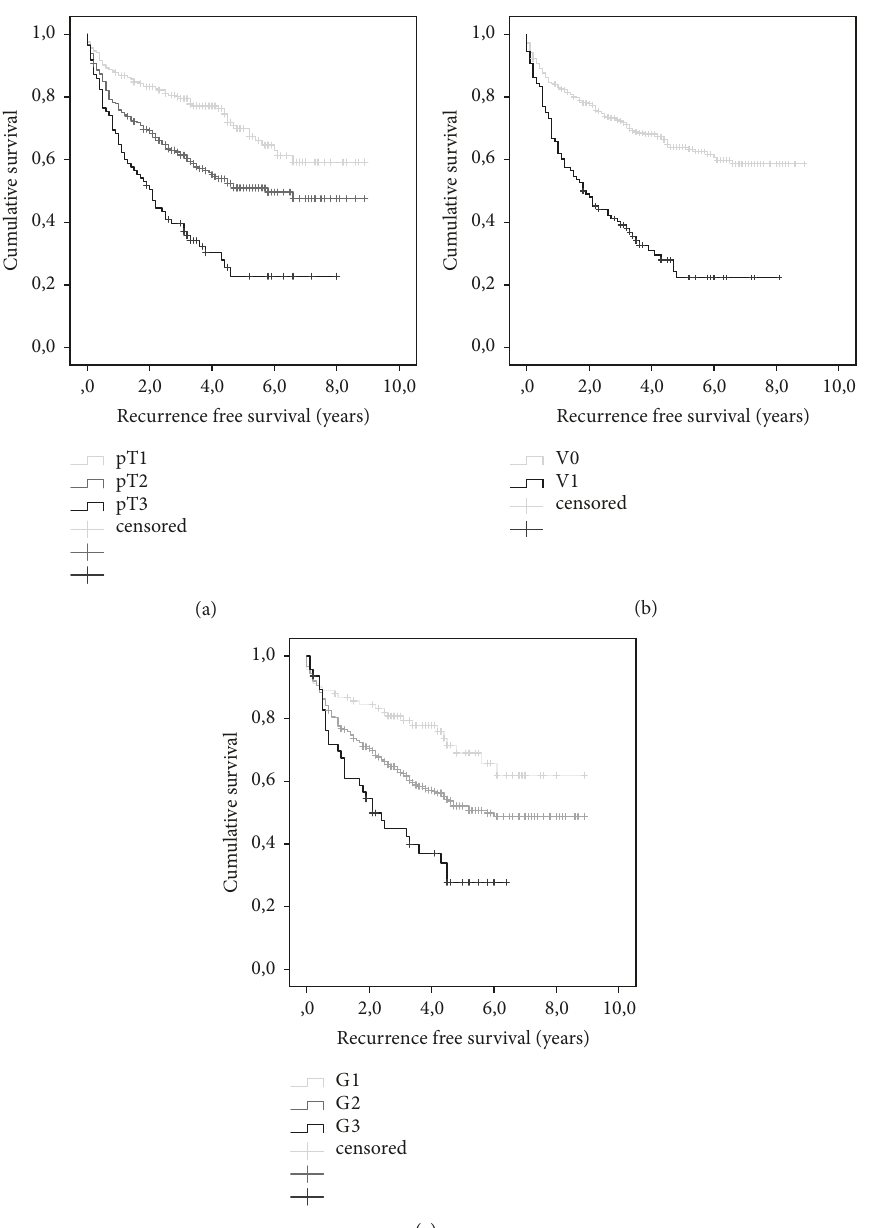
Figure 2: Recurrence-free patient survival in patients depending on primary tumor staging (a), vascular invasion (b), and grading (c). Statistical analysis by Log-rank test showed a significant reduced recurrence-free survival in patients with larger primary tumor stage, microvascular invasion, and higher tumor grading (all P-values=